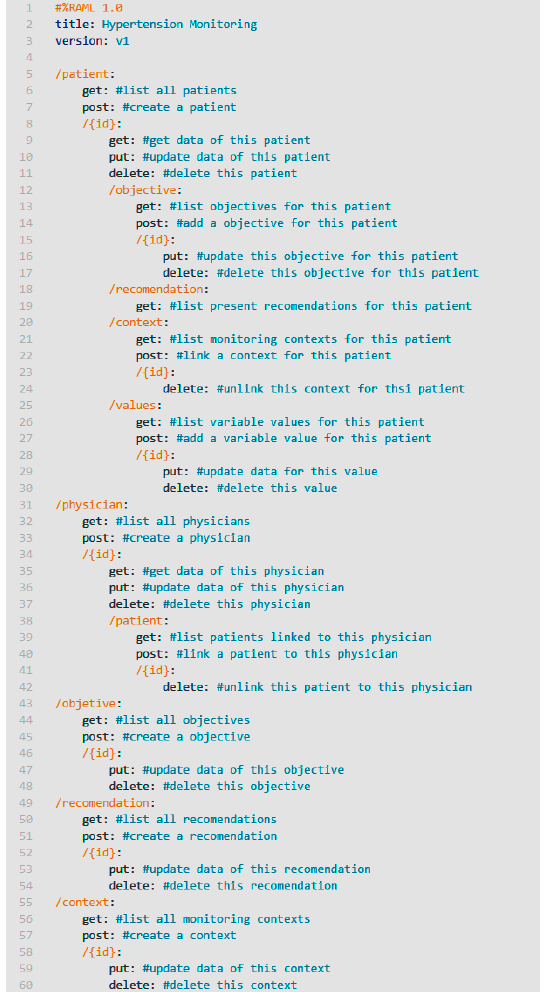
Figure 7. RESTful API definition in RAML.